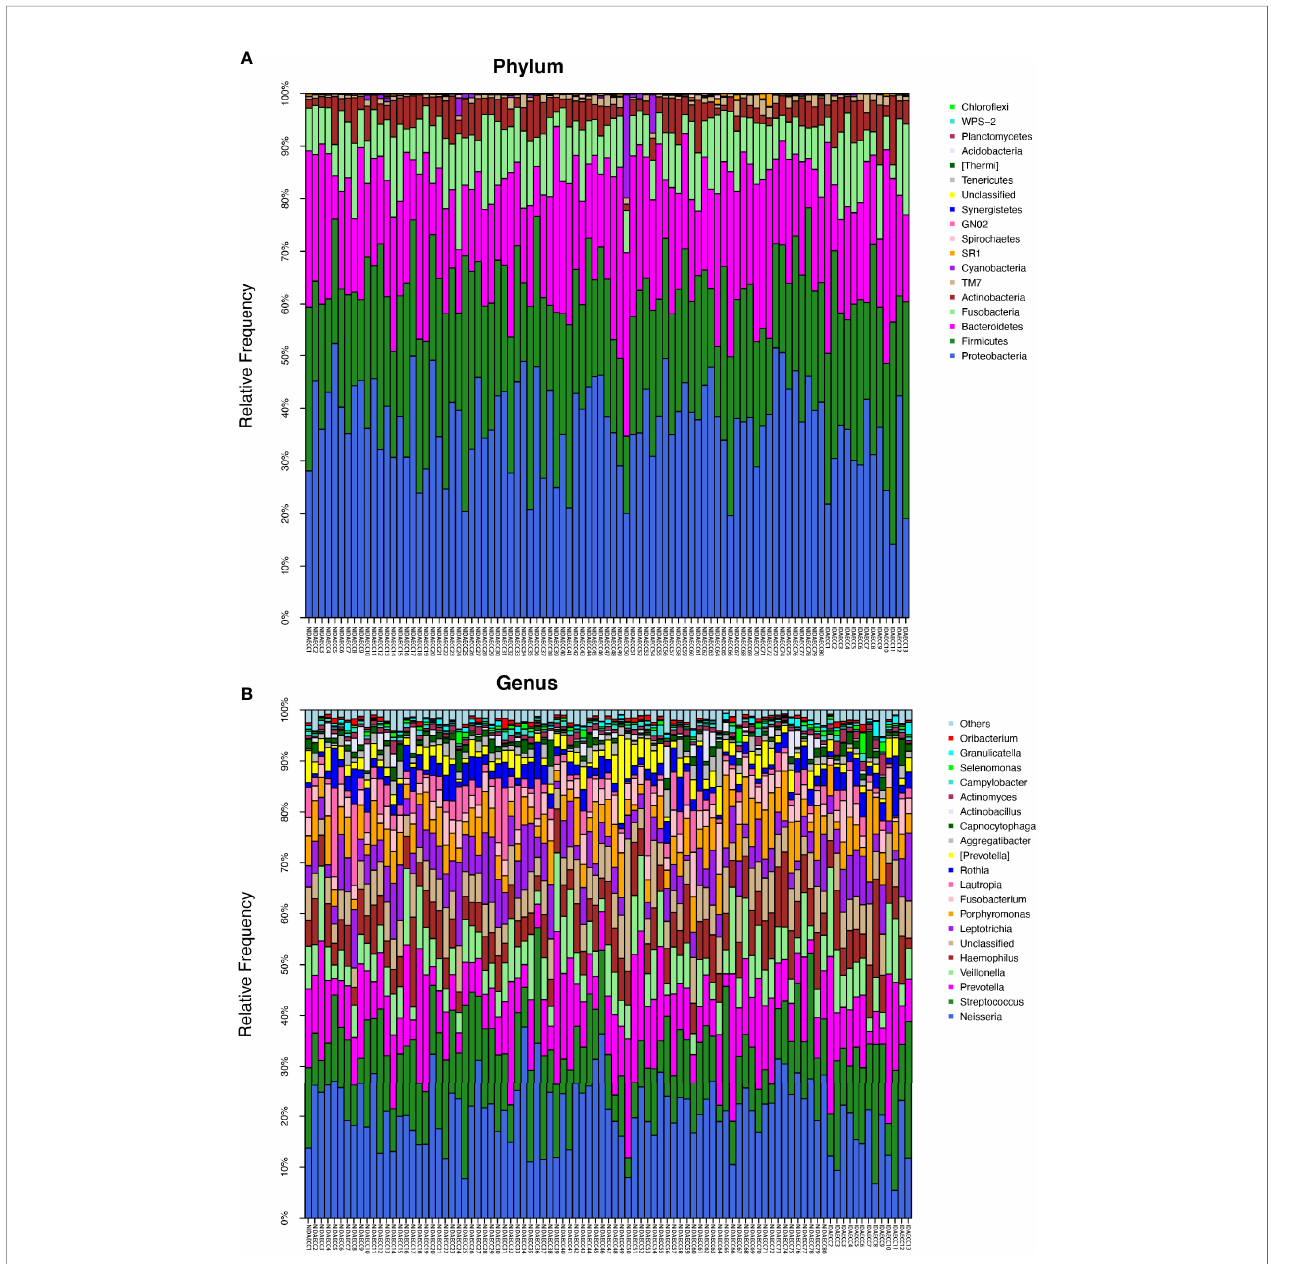
FIGURE 3 | (A) The composition of phyla with NIDA ECC and IDA ECC. Bar plot of percentage abundance at the phylum level in every sample. The horizontal axis is the name of each sample. They are NIDA ECC1-80 and IDA ECC1-13. (B) The composition of genera with NIDA ECC and IDA ECC. Bar plot of percentage abundance at the genus level in every sample. The horizontal axis is the name of each sample. they are NIDA ECC1-80 and IDA